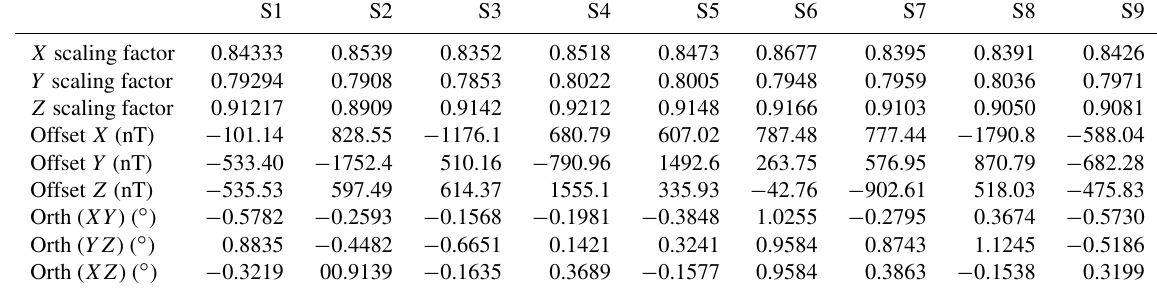
Table 2. The parameters of the linear calibration for sensors 1–9.